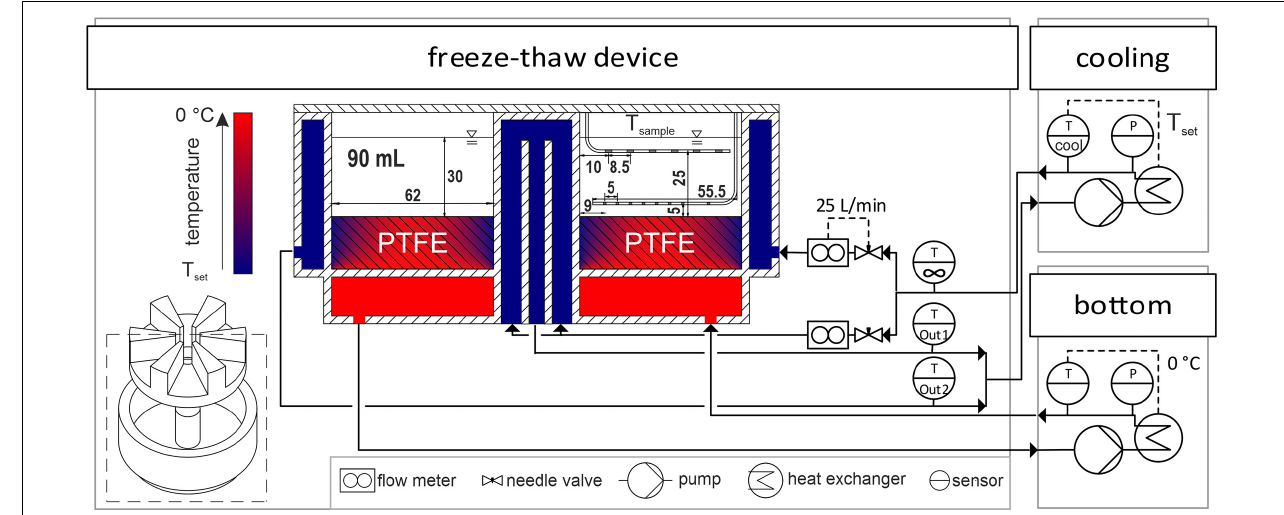
FIGURE 1 | Experimental setup. A piping and instrumentation diagram of the cryogenic device with the two individual cooling units to control the freezing chambers is displayed. Freezing chambers are visualized as a cross-section of the small-scale freeze-thaw device. Temperatures of cooling fluids and PTFE inlay are indicated by a gradient from T set to 0 ◦ C in blue to red, respectively. Inside the cross-section, sample temperature probes and dimensions in mm are shown as gray spots on the bent steel encapsulations in white. Pipes are represented by arrows. Hatched areas indicate solid stainless steel and